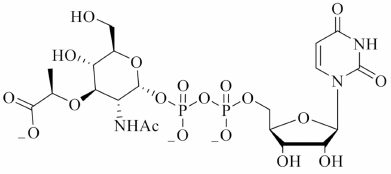
Figure 1. Structure of the natural substrate